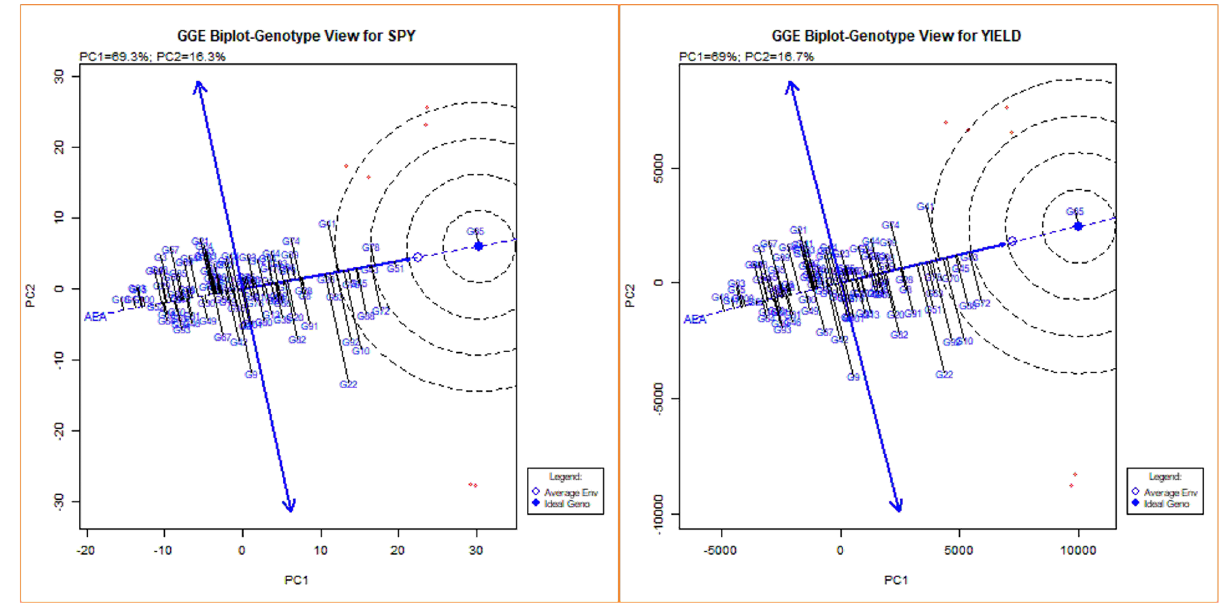
Figure 4. GGE biplot-Genotype view, including performance of test genotypes in comparison of to an estimated average environment and ideal genotype (For SPY and Yield PC2 of the data set. In the case of DFF, ideal genotypes were not found in the late type, but G93 (BK 49-180) and G102 (Nagina22) was identified as mid-early and early stable line. The hybrids viz ., G65 (IR68897A × IR-66R) and G51 (IR79156A × RPHR611-1) were found closer to ideal and average environments for GP but were not stable as they were placed farther from Average Environment Axis (AEA). G78 (EPLT104), G100 (IR 64) and G50 (IR79156A × 363-5) were next in the order and closer to AEA and was observed to be more stable for the trait GP. For NRT, G58 (IR68897A × RPHR619-2) was found to show the highest value across the environments while G75 (IR79156B) and G3 (APMS6A × KMR3) were most stable. In the case of plant height, G12 (APMS6A × Akshyad- han) and G100 (IR64) were most stable, and the general trend of stability showing closeness to AEA was found in most of the genotypes for this trait. G1 (APM6A × BCW56) was found ideal for panicle length with the longest panicle followed by G29 (IR58025A × IR-66R), whereas G2 (APMS6A × EPLT104) was found most stable. G102 (Nagina22) was observed to have one of the shortest panicle lengths among the genotypes. For panicle weight, G73 (APMS6B) and G72 (IR68897A × RPHR1096) were most stable with the highest panicle weight as ideal genotypes for this trait. G67 (IR68897A × SG27-105) and G5 (APMS6A × RPHR1005) were found ideal genotype for SF and most of the genotypes centers around and found ideal for TW. Hybrid G18 (APMS6A × RPHR1096) and G17 (APMS6A × BK-49–180) were identified as stable and ideal genotype for SPY and YLD followed by G83 (IR40750R), G15 (APMS6A × RPHR611-1) and G100 (IR64). Which-won-where polygon plots formed by linking the farthest genotypes from the biplot origin, including all the remaining genotypes in the polygon and those at the vertex, are the winning genotypes in the specific sector containing environments 16 . There were five sectors identified for, which won where the plot (Fig. 5 and Supplementary Figure 4). Cross of G65 (IR68897A × IR-66R) was the winner in the sector where the four envi- ronments were located and similarly G65 (IR68897A × IR-66R) was the vertex genotype for YLD where E1B, E2B, E1C and E2C were located. For DFF, three sowing dates placed in three distinct sectors, early environments E1A and E2A fell in the sec- tor in which G83 (IR40750R) and G47 (IR79156A × IR-66R) were the vertex cultivars, showing they were the best-suited genotypes for normal sown environments E1A and E1B (Non-heat stress environment). Similarly, G11 (APMS6A × IR-66R) was suited for second sowing environments E1B and E2B (Moderate heat stress envi- ronment), and G79 (KMR3) was best suited for late sown environments E1C and E2C (High heat stress environ- ment). For GP, G94 (RPHR1096) was best suited in E1A and E2B and remaining environments placed together and G60 (IR68897A × RPHR517), G65 (IR68897A × IR-66R) and G69 (IR68897A × RPHR611-1) were the most adapted genotypes across these environments. For NRT, G5 (APMS6A × RPHR1005) was the best suited in E1A, E2A; G10 (APMS6A × RPHR695-1) in E1B, E2B; G69 (IR68897A × RPHR611-1), G14 (APMS6A × 363–5) and G38 (IR79156A × EPLT104) in E1C, E2C. The field view of G38 (IR79156A × EPLT104) in E2C was represented in Fig. 6. For PH, G101 (PA6444) and G23 (IR58025A × RPHR1005) was winners for E1C and E2C and G3 (APMS6A × KMR3) for the remaining four environments. G78 (EPLT104) and G43 (IR79156A × IR40750R) showed no change in PL in early and late sown environments. G73 (APMS6B) and G65 (IR68897A × IR- 66R) were winners for PW in late sown environments. G72 (IR68897A × RPHR1096) for moderate stress and G96 (NDR359), G39 (IR79156A × KMR3) for early sown environments. G35 (IR58025A × BK-49–180), G41 (IR79156A × RPHR1005) and G78 (EPLT104) were the vertex genotypes for stress environments (E1B, E2B and E1C, E2C) respectively. For TW, G57 (IR68897A × KMR3) and G59 (IR68897A × RPHR1005)